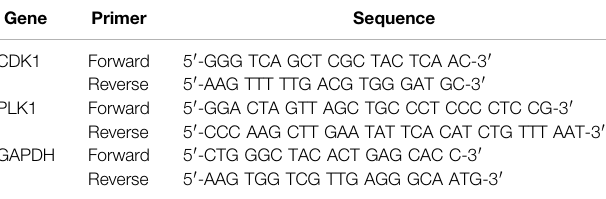
TABLE 1 | Primer sequences for the RT-PCR.